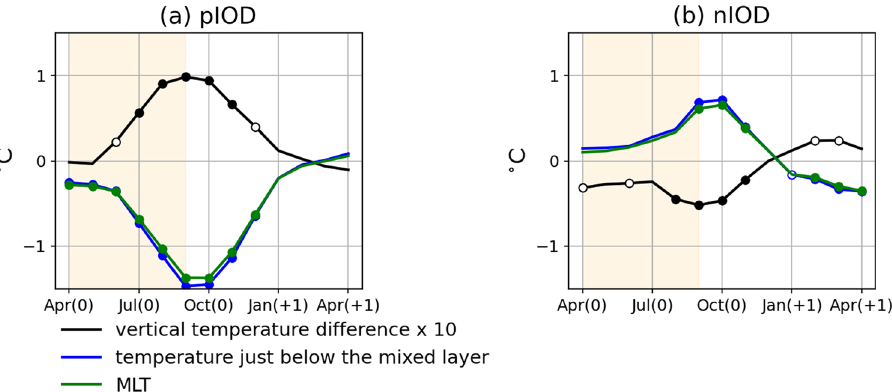
Figure 5. Vertical temperature difference during pIOD and nIOD years. As in Fig. 4, but for vertical temperature difference multiplied by 10 (black), temperature just below the mixed layer (blue), and MLT (green) anomalies (in °C) for ( a ) the pIOD and ( b ) the